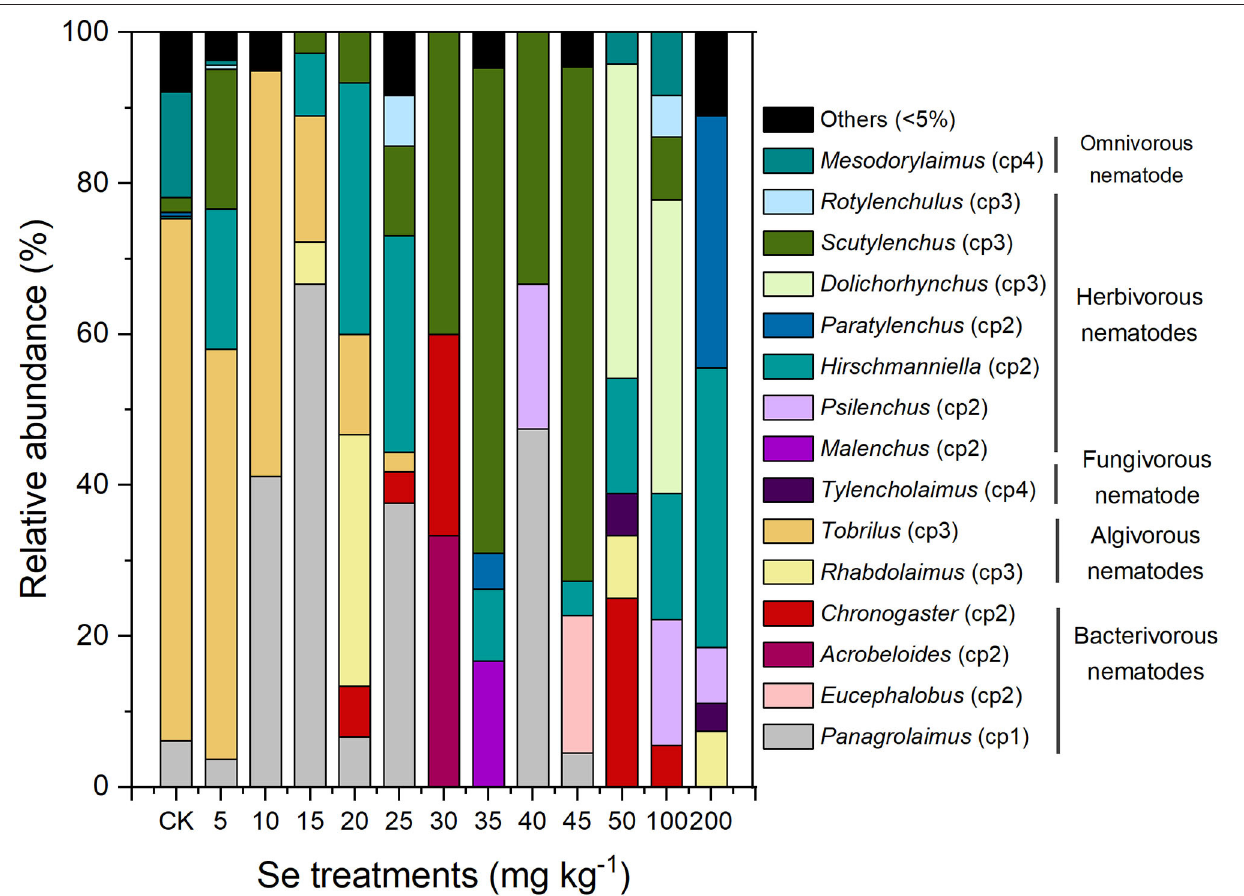
difference in relative abundances of the cp-3 taxon in different treatment